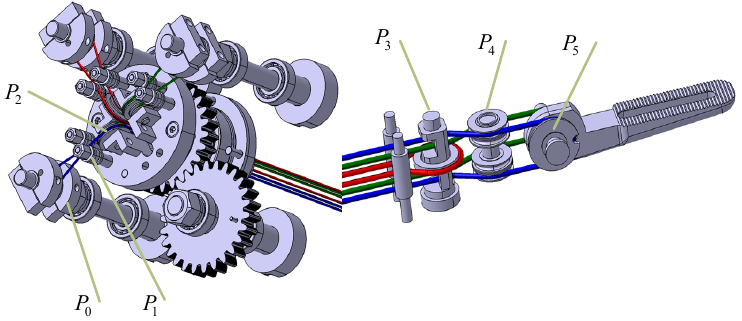
Figure 1. The cable-driven transmission structure of surgical instruments.